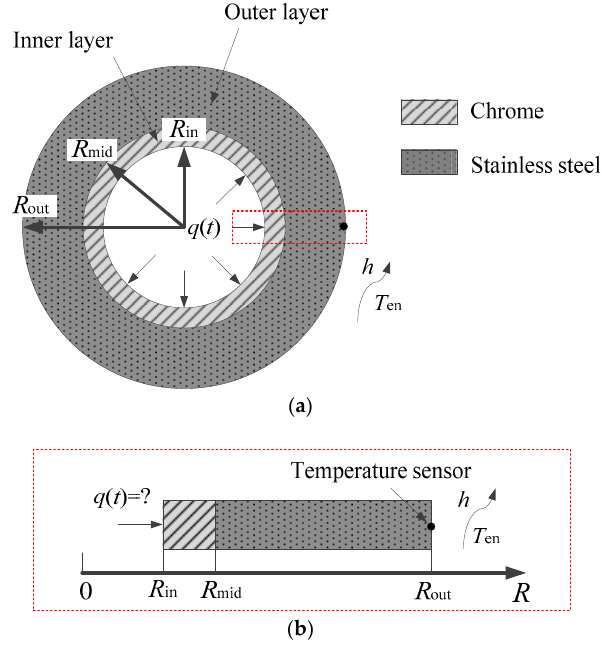
Figure 1. Simplified physical model for the heat transfer process of a gun barrel: ( a ) Cross-section structure of a gun barrel in the axial direction; and ( b ) simplified one-dimensional heat transfer model along the radial ( R ) direction.